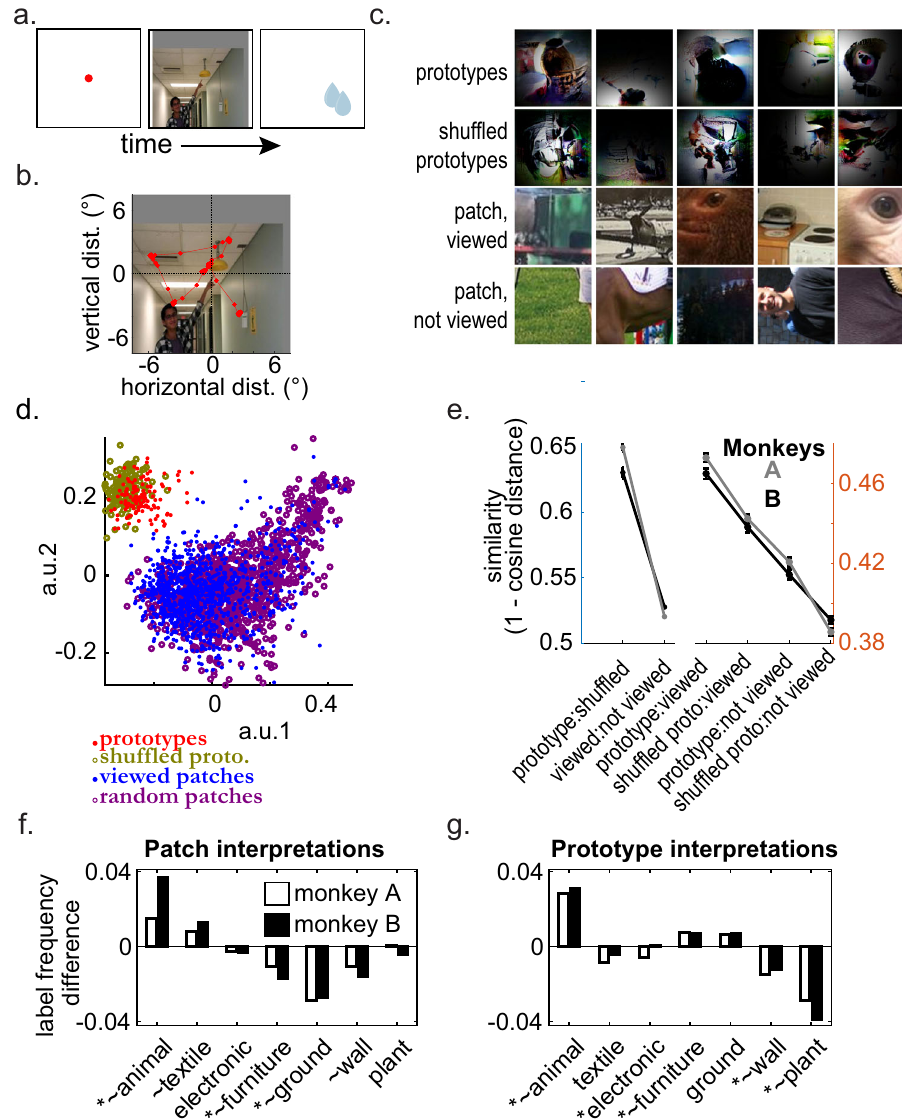
Fig. 4 Evidence for active encoding based on free viewing. a Schematic of free viewing task fl ow. b Example trial of animal A ’ s eye-tracked path, beginning at fi xation (0,0)° and making ~5 saccades (red dots/line). c Example prototypes, shuf fl ed prototype surrogates, scene patches viewed by the monkeys, and scene patches not viewed by the monkeys. Black masks on prototypes and shuf fl ed prototype surrogates show an estimate of the location of the receptive fi eld center. d Scatter plot representation of the image fragment types in c in AlexNet fc6 space (red = prototypes, gold = shuf fl ed prototypes, blue = viewed patches, purple = non-viewed (random) patches). e Mean similarity of fc6 representations between image sets denoted on the horizontal axis. Gray for monkey A, black for monkey B. Left panel compares prototypes and viewed patches with their corresponding (same image type) random control. Right panel shows a similarity between image sets curated by viewing patterns on photos to synthesized images. Standard error bars are shown ( n = distance values between prototypes